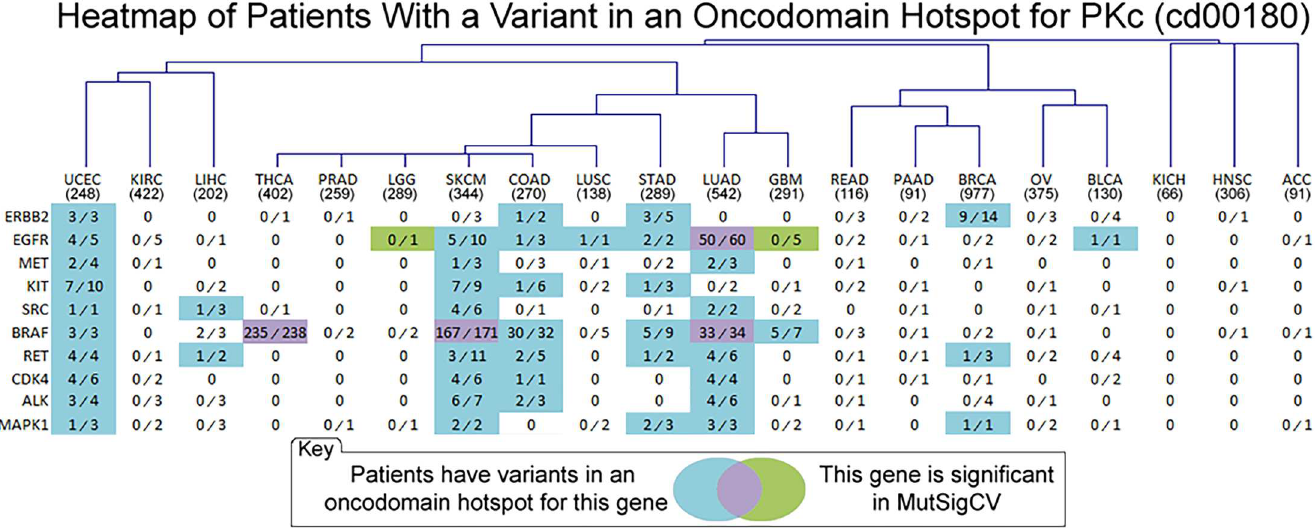
Fig 6. Heatmap of Patients with a Variant in an Oncodomain Hotspot for the PKc domain. Visual representation and hierarchical clusteringof oncodomain hotspots on genes that were significantin MutSigCV. For each gene in each cancer type, the number of patients in oncodomain hotspots is quantifiedand the cell is color-codedif the gene had any patients in oncodomain hotspots (blue), if it was significantin MutSigCV (green)or both (purple). Only the top ten genesbased on the gene name’s co-occurrence with the “cancer” MeSH term are shown. Here, cancer types are groupedvia hierarchical clustering to show similar mutational patterns. Enumeratedin each cell are the proportionof patients with a somatic variant in an oncodomain hotspot (numerator)comparedto the number of patients that had a somatic variant anywhere in the protein domain region(denominator).